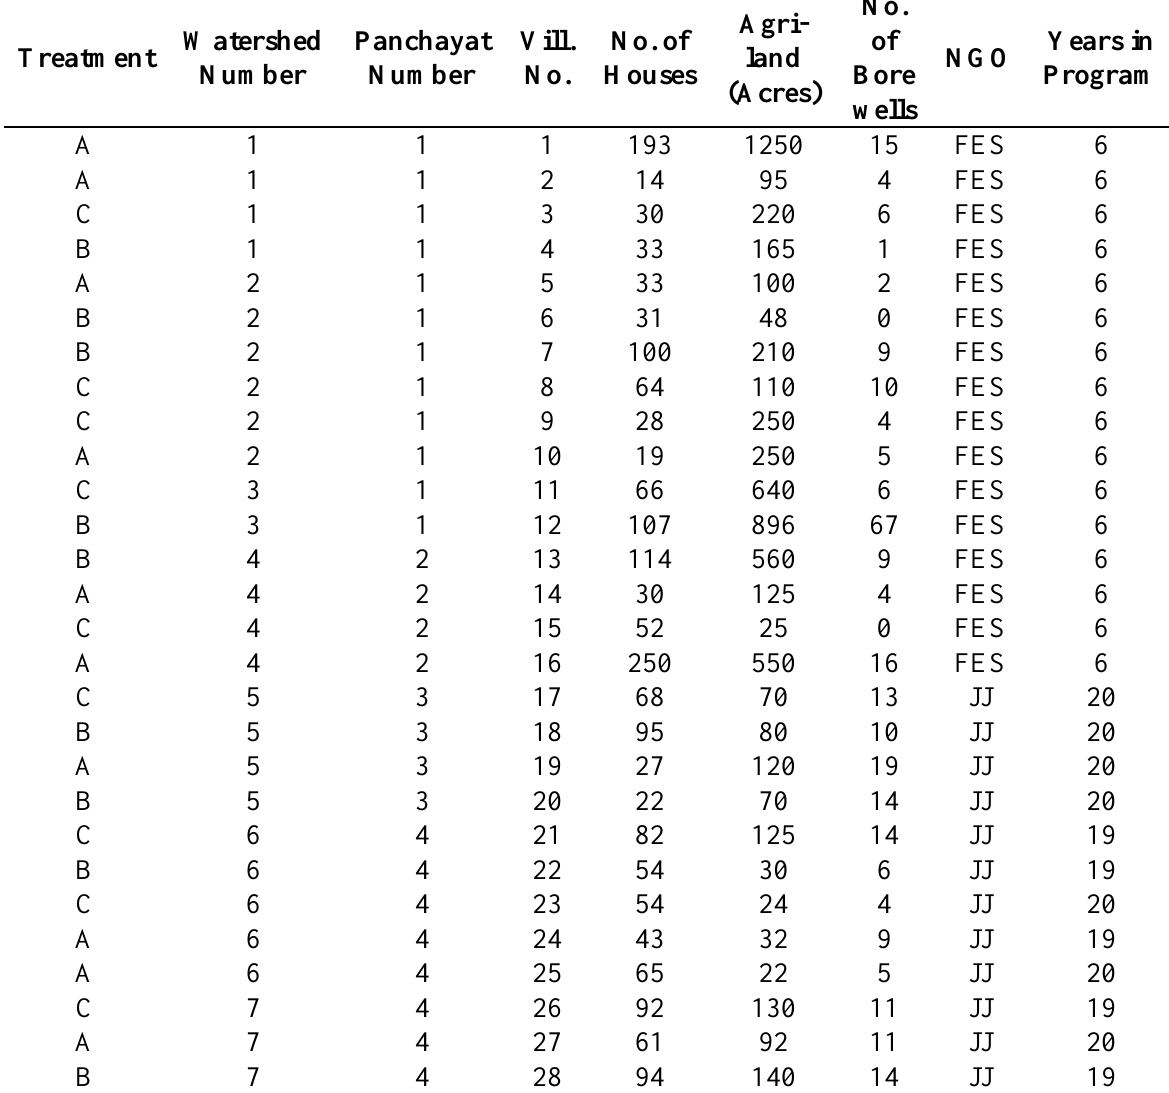
Table A2.1 Study Locations Summary